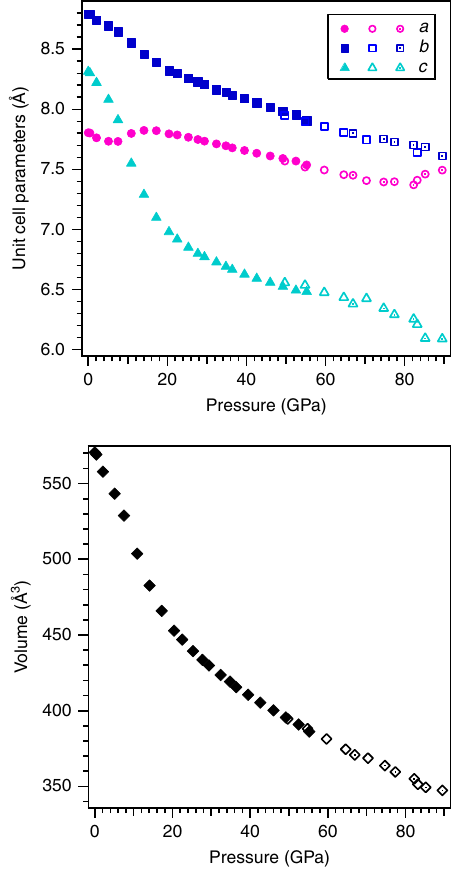
Fig. 2 The evolution of the unit-cell parameters of hurlbutite, CaBe 2 P 2 O 8 , along the compression. Filled, open and open with dots symbols correspond to high-pressure room-temperature experiments 1 – 3 , respectively. The errors are smaller than the size of the